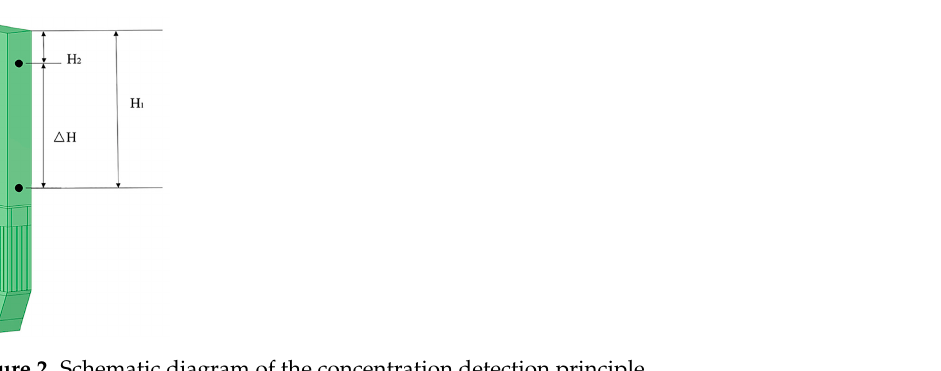
Figure 3. Grids of different structures. ( a ) Grids corresponding to different lengths of the TES. ( b ) Grids corresponding to different inlet angles.